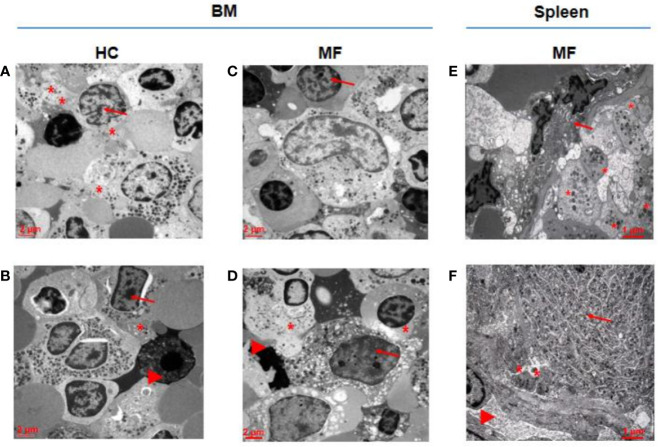
In MF spleen, megakaryocytes are frequently co-localized with platelets in the proximity of blood vessels while these cells are seldom associated with platelets in MF BM. Representative megakaryocytes from bone marrow (BM) of two HC (A, B) and two MF (C, D), and two MF spleen (E, F). Fifty percent of megakaryocytes from BM of HC and from spleen of MF patients are closely associated with platelets while the megakaryocyte shown in D is the only one out of 60 cells analyzed found to be associated with platelets in BM from these patients. Platelets, megakaryocytes, and blood vessels are indicated by *, arrows and arrowheads, respectively (for further detail see legend of Figure 1). Magnification 3,000× for A, B, C, D and 4,400× for E, F. Scale bars = 2 and 1 μm, as indicated.